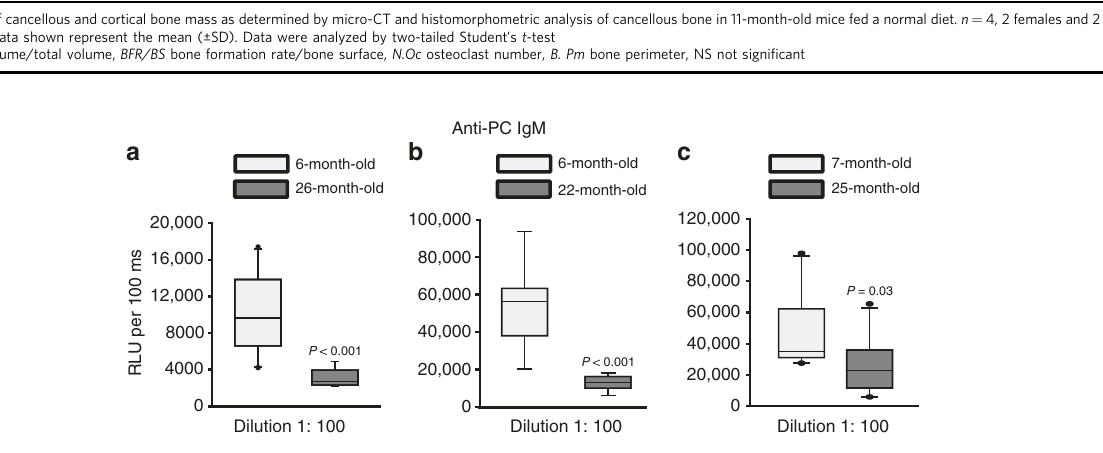
Fig. 6 Aging is associated with reduced anti-PC IgM levels. Quanti fi cation of anti-PC IgM levels by ELISA in serum of a 6- ( n = 10) and 26- ( n = 9) month- old female C57BL/6 J mice; b 6- ( n = 9) and 22- ( n = 8) month-old female C57BL/6 J mice, and c 7- ( n = 10) and 25- ( n = 10) month-old female C57BL/6 J mice. Data analyzed by Rank Sum test. Data shown represent the mean (±SD). RFU: Relative luminescence